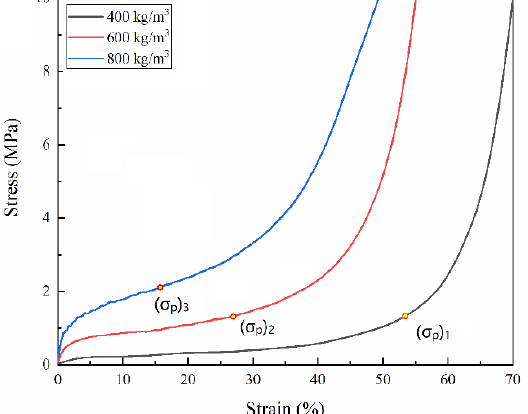
Figure 11. The peak stress generated in different foams when absorbing the same amount of energy at 23 °C ± 2 °C.